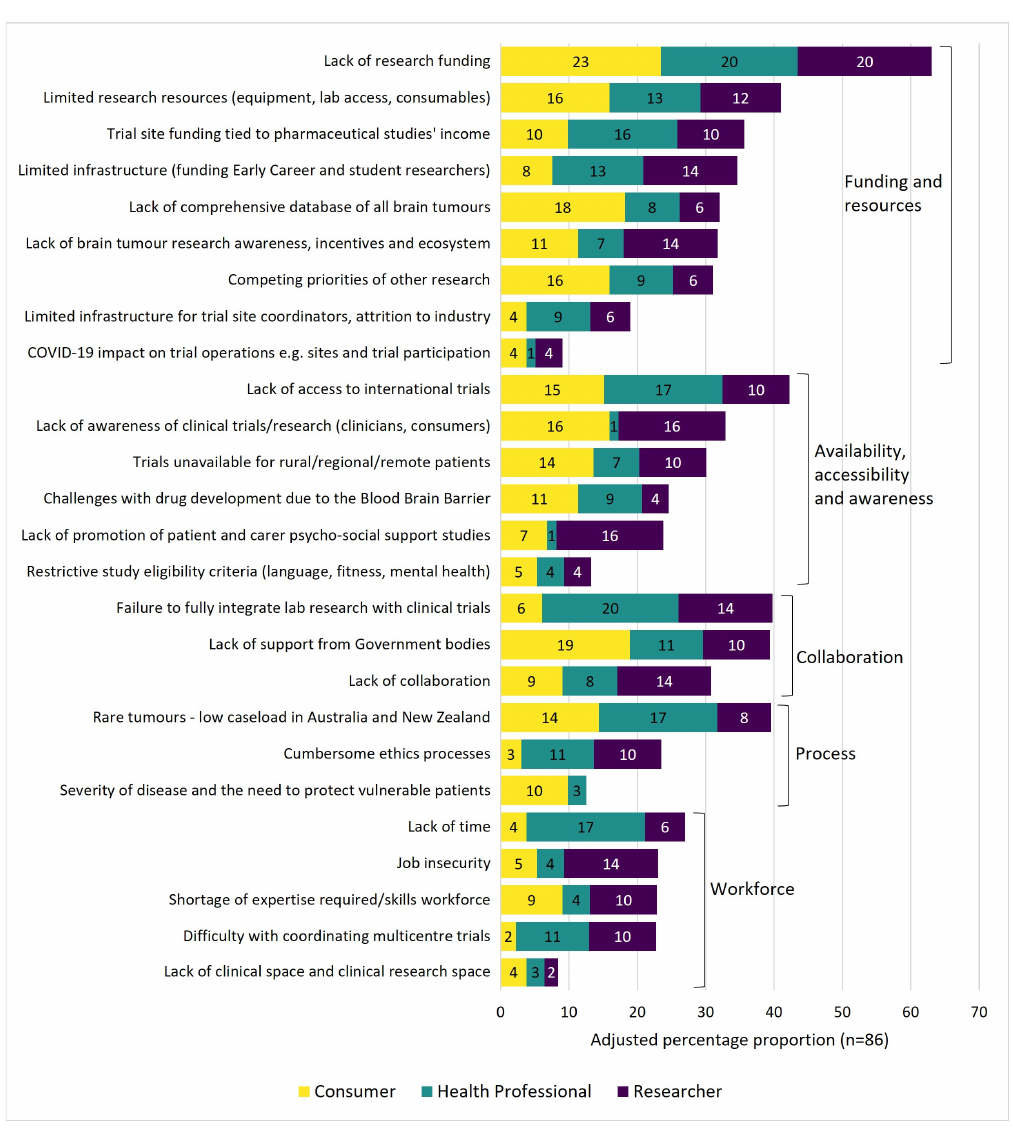
Figure 2. The adjusted proportion of participants by sub-group who selected research barriers in the top ten.